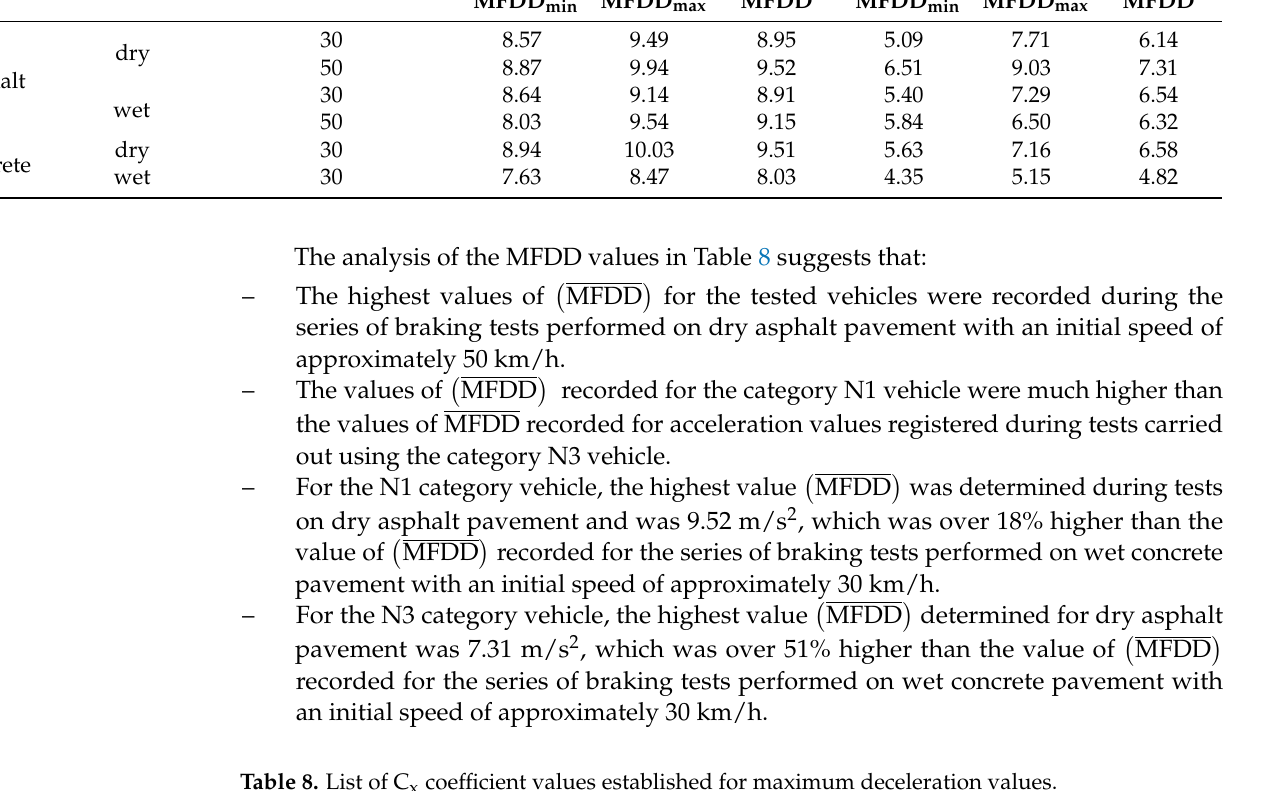
Table 8. List of C x coefficient values established for maximum deceleration